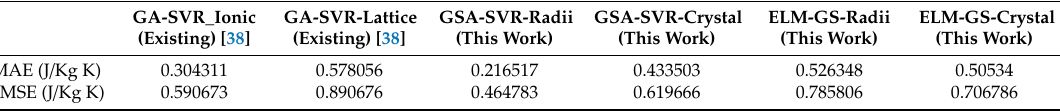
Figure 14. Comparison between the present and existing crystal lattice distortion-based models using the root-mean-square error metric. Table 4. Performance comparison between the present and existing